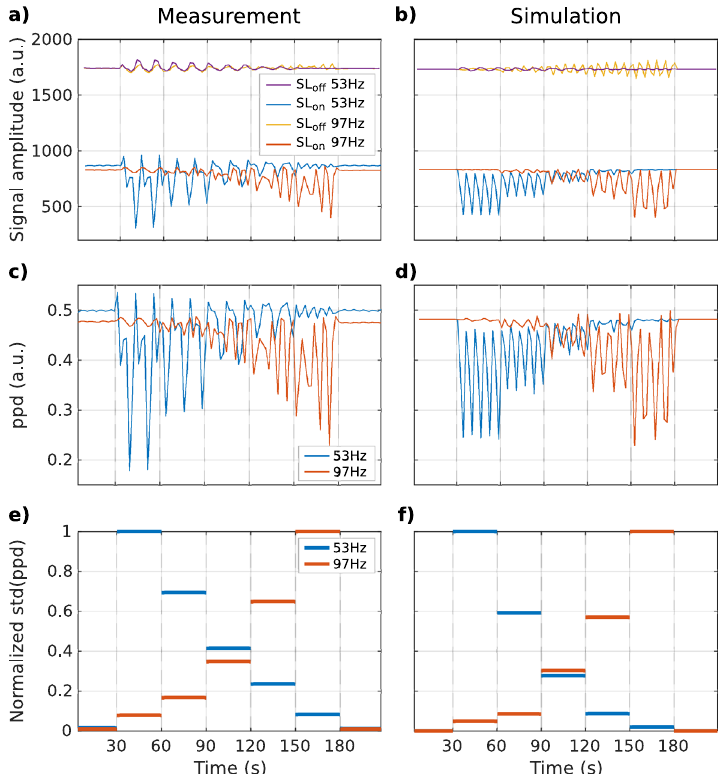
Figure 6. Sequence response to a composite signal. ( a ) Measured and ( b ) simulated SL on and SL off signals as a function of time for F SL set at 53 Hz and 97 Hz. ( c ) Measured and ( d ) simulated ppd between SL on and SL off as a function of time for the two frequencies used in ( a ). ( e ) Measured and ( f ) simulated normalized frequency component every 30 s